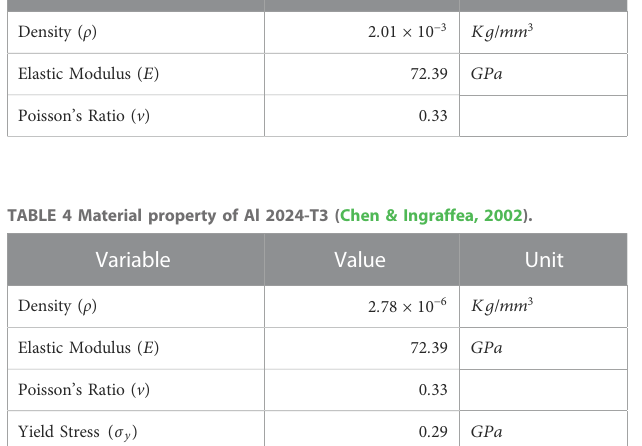
TABLE 3 Material property of wall and impactor (Chen & Ingraffea, 2002).